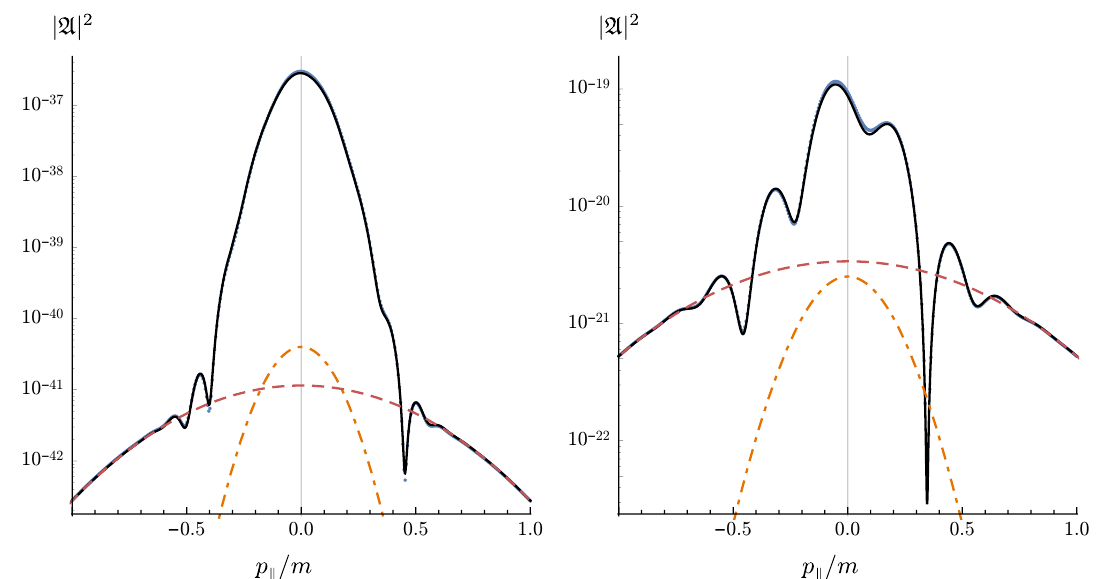
Figure 2 . Logarithmic plots of the pair production probability as a function of the longitudinal mo- mentum p =m , with p = 0. The strong (cid:12)eld is a Sauter pulse and the weak (cid:12)eld is given by (2.15). k ? The parameters are E = 0 : 033 E crit and (cid:13) = 2 : 2 for the left plot, E = 0 : 066 E crit and (cid:13) = 2 : 43 for the right plot, and (cid:13) slow = 0 : 2 and " = 10 (cid:0) 3 in both cases. The curves and dots are obtained as de- scribed in (cid:12)gure 1, where A 0 (cid:25) (cid:0) (cid:12) (cid:3) is obtained from (4.20) and A 1 is obtained by multiplying